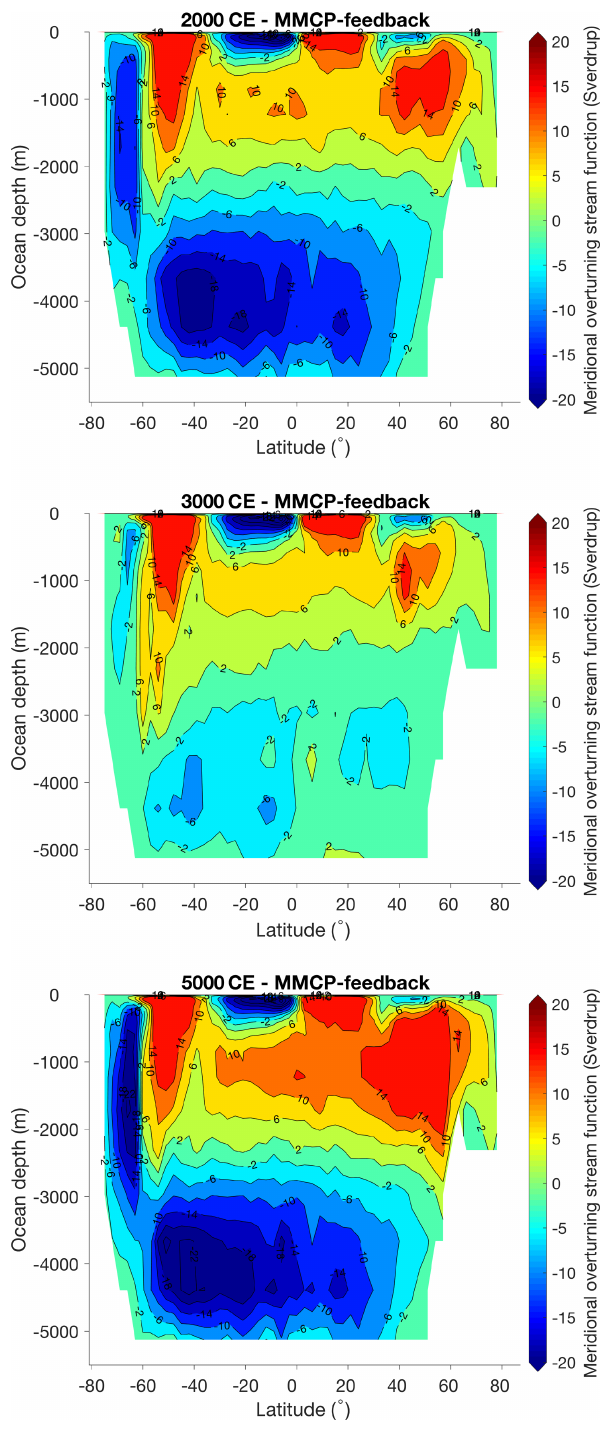
Figure 10. Meridional overturning stream function for the global ocean at 2000CE, 3000CE, and 5000CE using forcing scenario